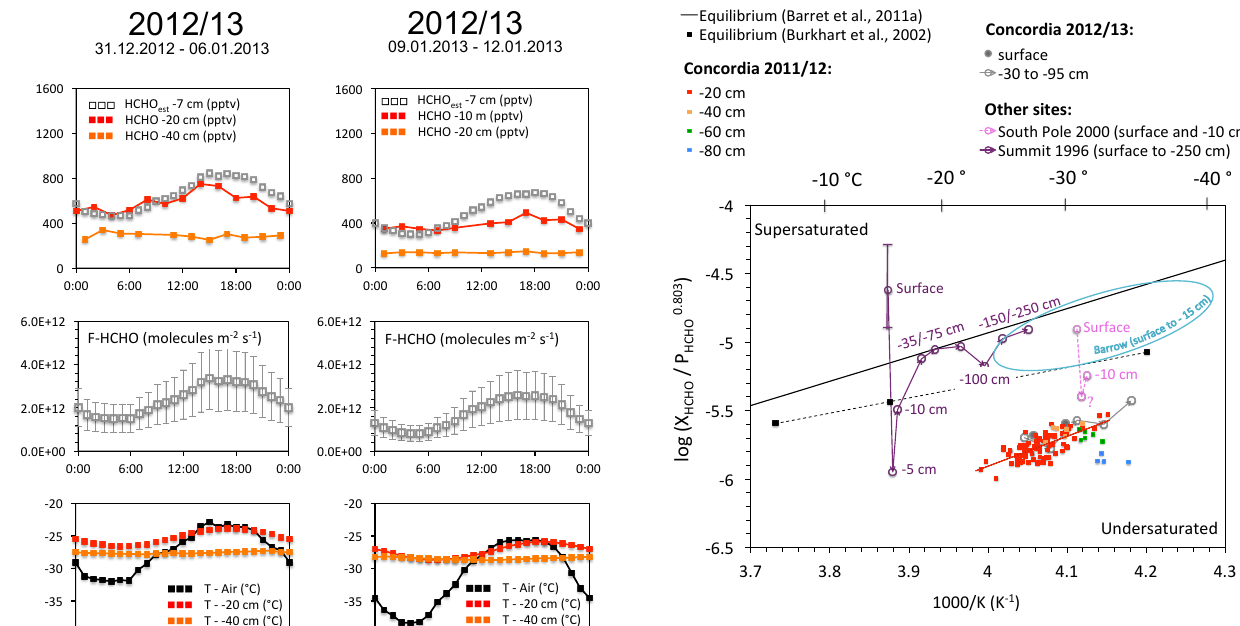
Figure 7. Arrhenius plot of the partitioning coefficient K(T ) for HCHO in firn air and snow of Concordia, South Pole, Summit, and Barrow versus T − 1 . The thermodynamic equilibrium as estimated by Barret et al. (2011a) is shown as a black line. Barrow data, which use ambient air and not firn air measurements, are situated in the blue ellipse (Barret et al., 2011b). See discussion in text. Summit snow temperatures were calculated after Jun et al.